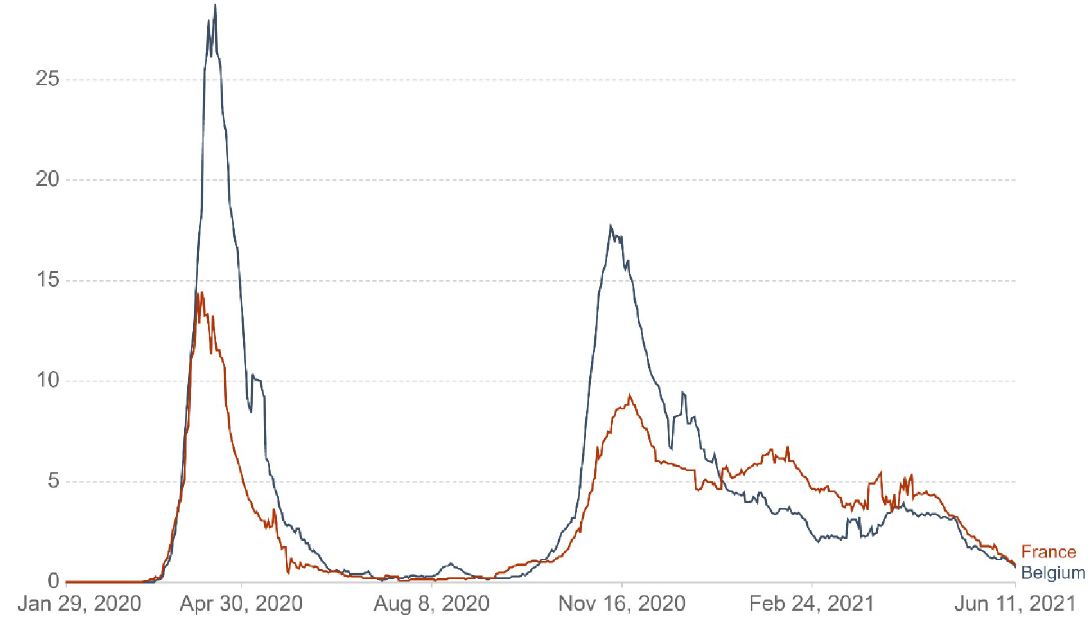
Fig 2. Daily new confirmed COVID-19 deaths per million people in Belgium and France.